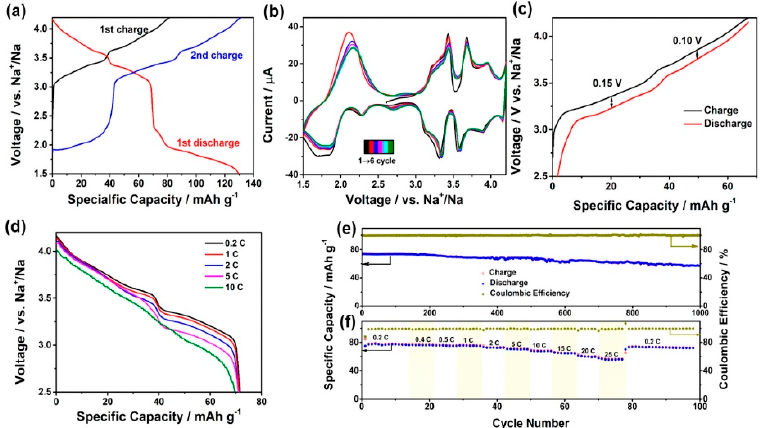
Figure 2. ( a ) Charge and discharge profiles of P2-layered Na 0.7 [Mn 0.6 Ni 0.4-x Mg x ]O 2 with x = 0.02 (MNM-2) between 1.5 and 4.2 V. ( b ) CV curves of MNM-2 between 1.5 and 4.2 V (scan rate: 0.1 mV · s − 1 ). ( c ) Charge and discharge profiles of MNM-2 in the second cycle between 2.5 and 4.2 V. ( d ) Charge and discharge profiles of MNM-2 at different current densities from 0.2 to 10C. ( e ) Cycle performance at 1C for 1000 cycles. ( f ) Rate capability of MNM-2 from 0.2 to 25C between 2.5 and 4.2 V. Reproduced with permission from [73]. Copyright 2019 The American Chemical Society.